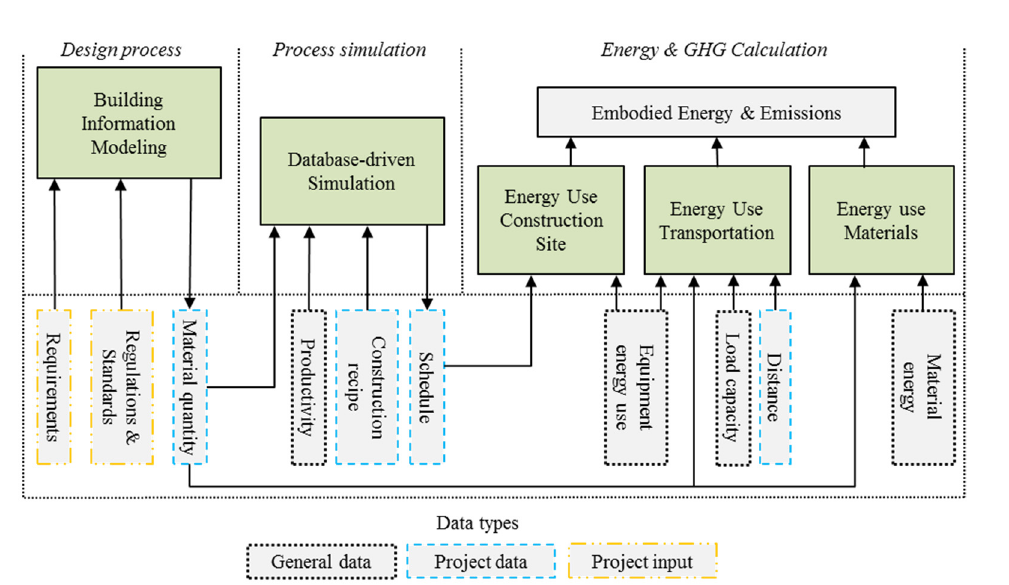
Figure 1. The model for assessing embodied energy associated